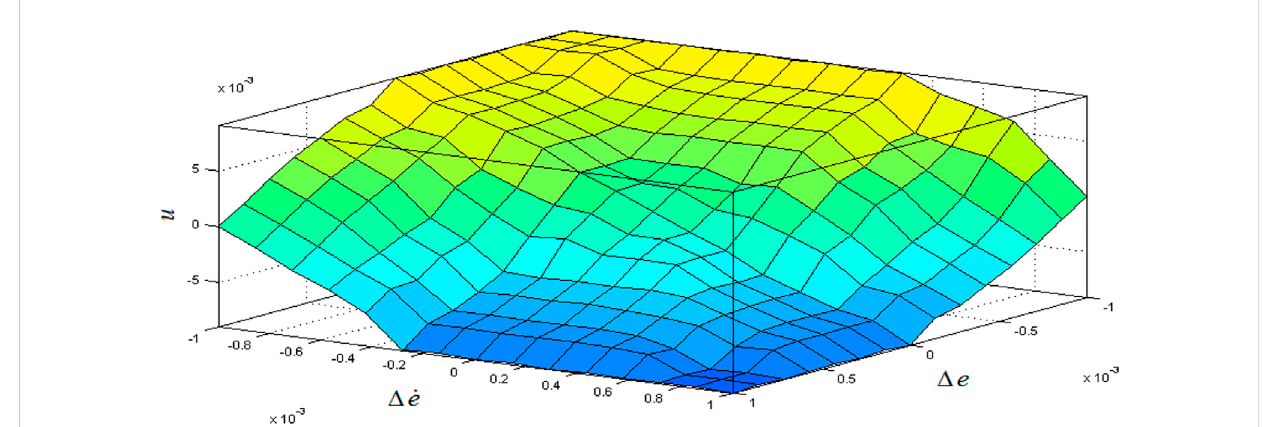
FIGURE 4 Signal surface plot with ( Δ e ) and ( Δ _ e )